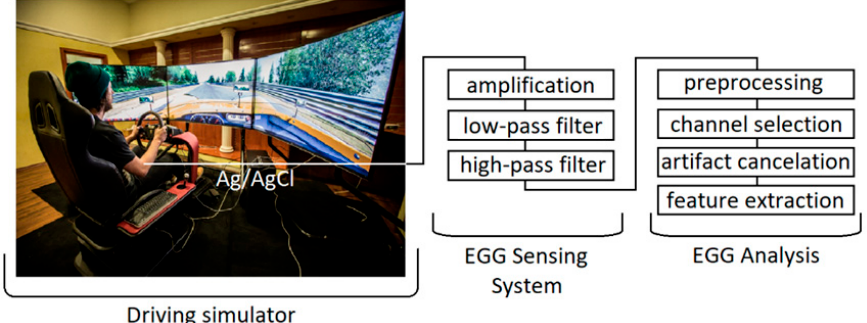
Figure 5. Nervtech's 4DOF motion car driving simulator during driving simulation on the left panel. The EGG sensing system and steps performed for SS assessment (EGG analysis) are presented on the right